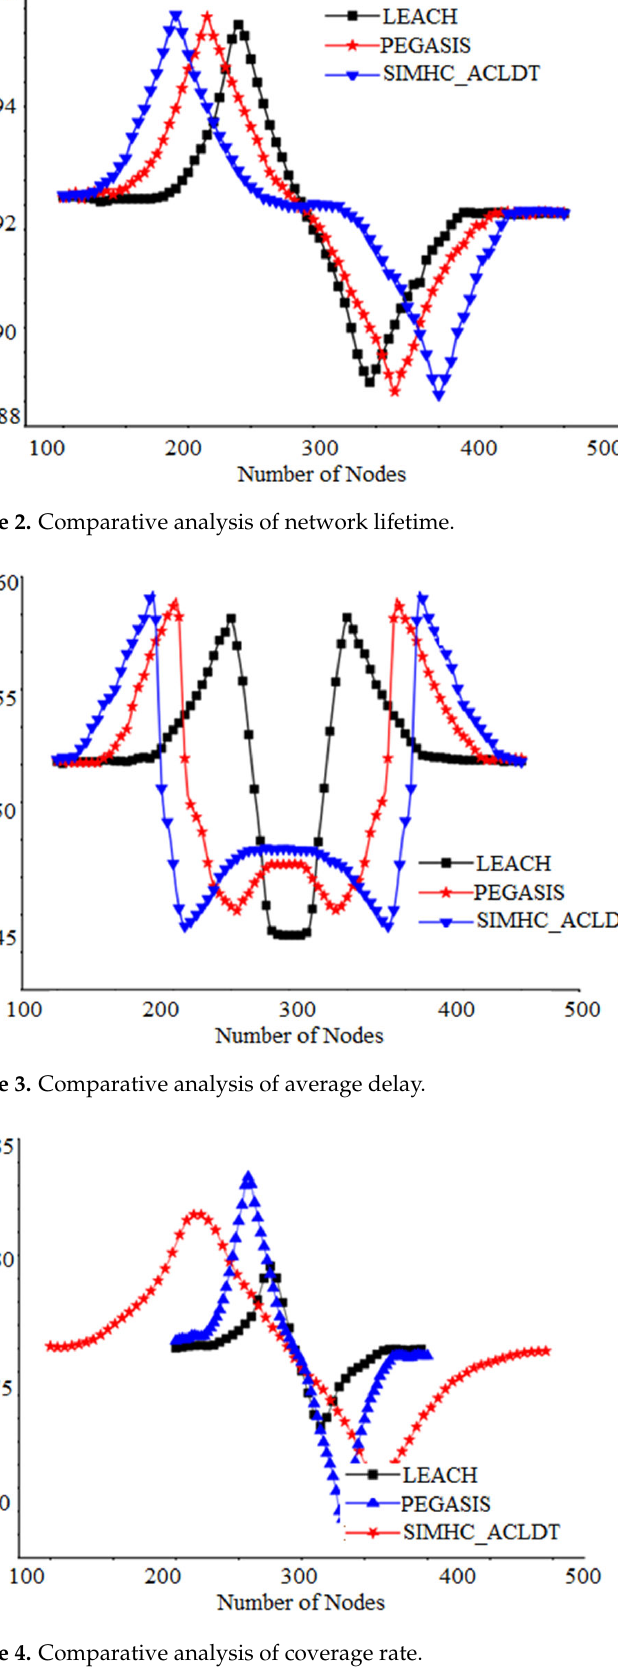
Figure 4. Comparative analysis of coverage